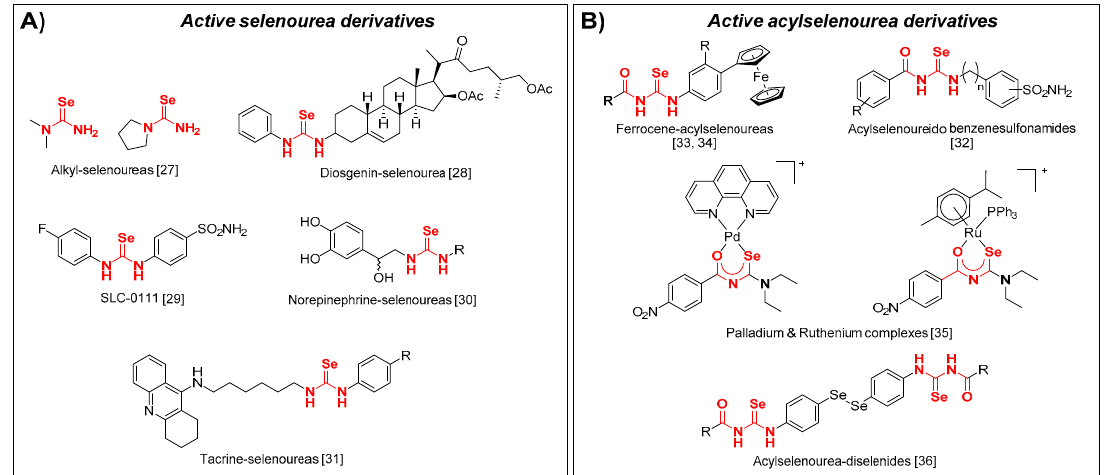
Figure 1. Selenourea ( A ) and acylselenourea ( B ) derivatives with an antioxidant and/or anticancer activity.